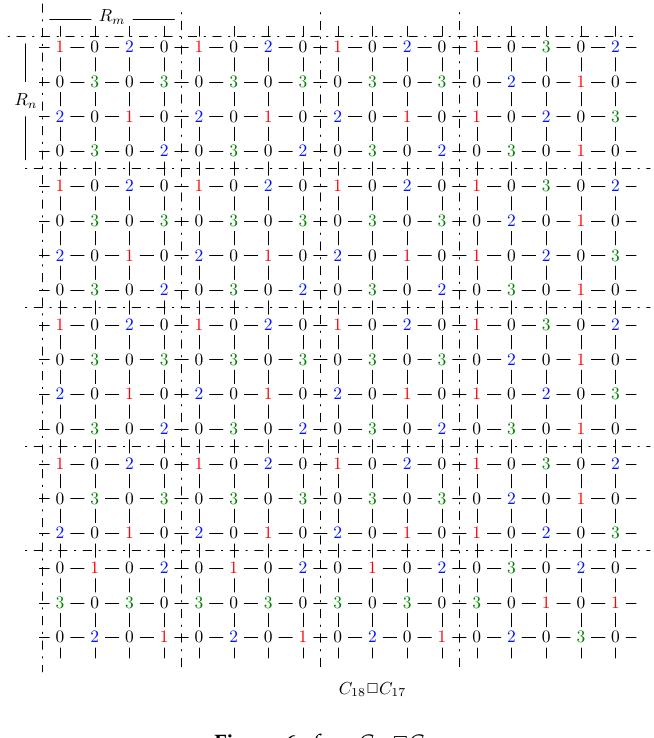
Figure 6. f on C 18 2 C 17